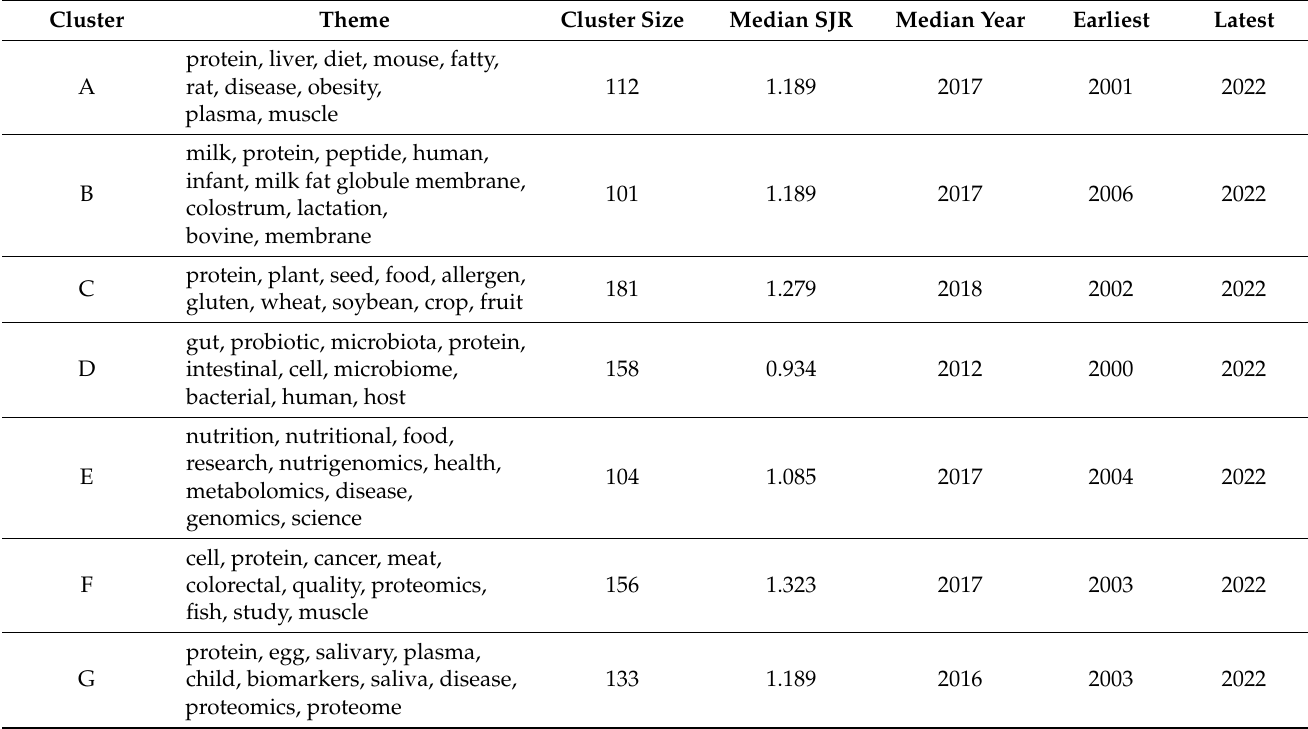
Table 2. Themes of Nutrition Proteomic Research 1.